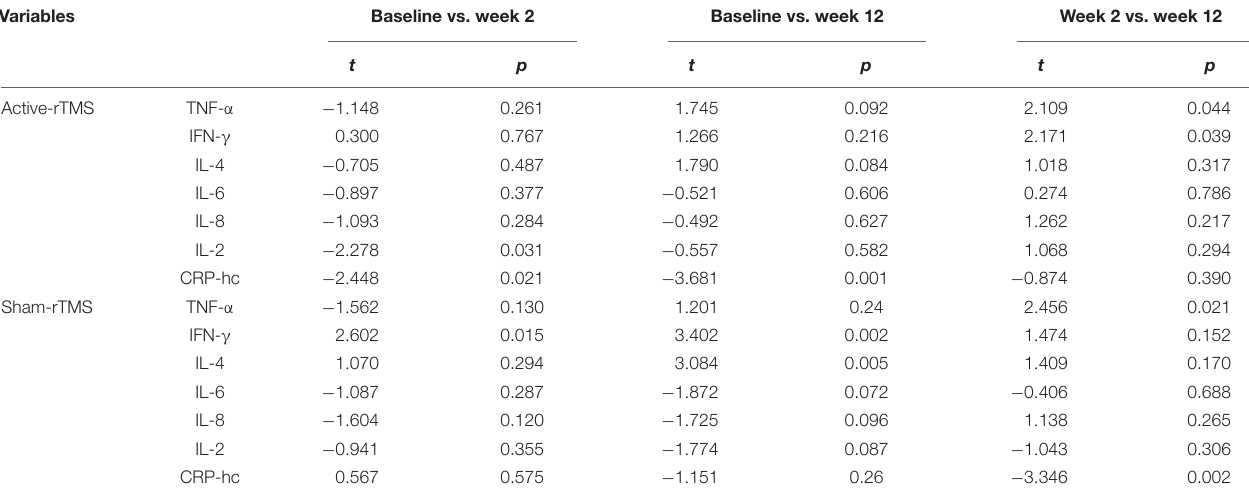
TABLE 4 | Self-controlled comparisons for serum levels of inflammatory cytokines before and after treatment in patients with depression.